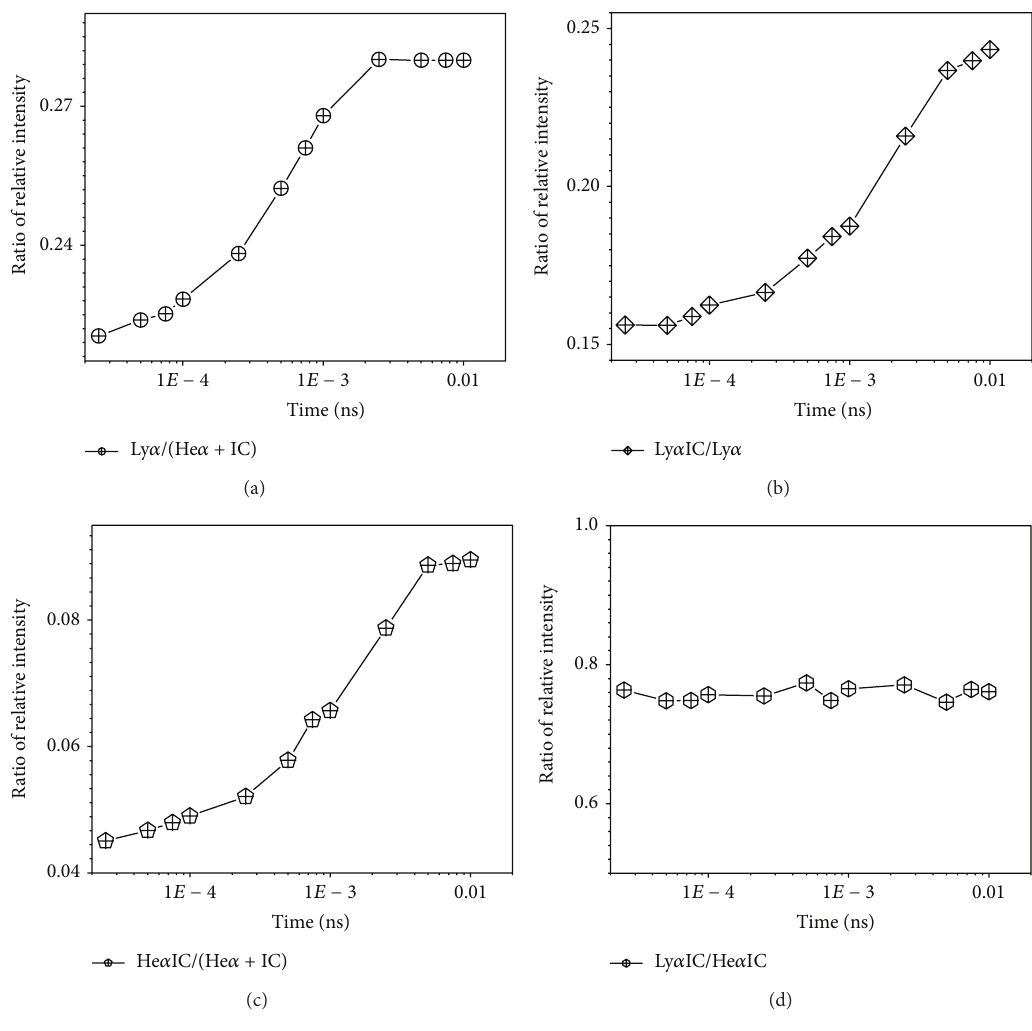
Figure 2: Variation of some transition intensity ratio with